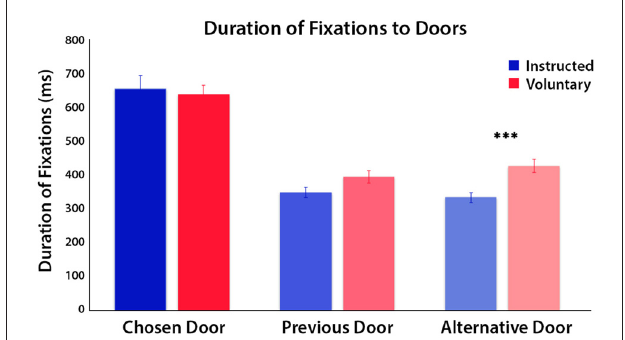
FIGURE 2 | Mean duration of fixations on each of the doors for Instructed (blue) and Voluntary (red) decisions, during the second half of the trial when the doors were visible. Results of a three-way ANOVA reveal significant differences in fixation duration to the three doors between conditions ( p < 0.001). The time spent fixating on the chosen door and previous door did not differ between conditions but time spent fixating on the alternative door, which was still available to choose, was greater in Voluntary trials ( ∗∗∗ p <